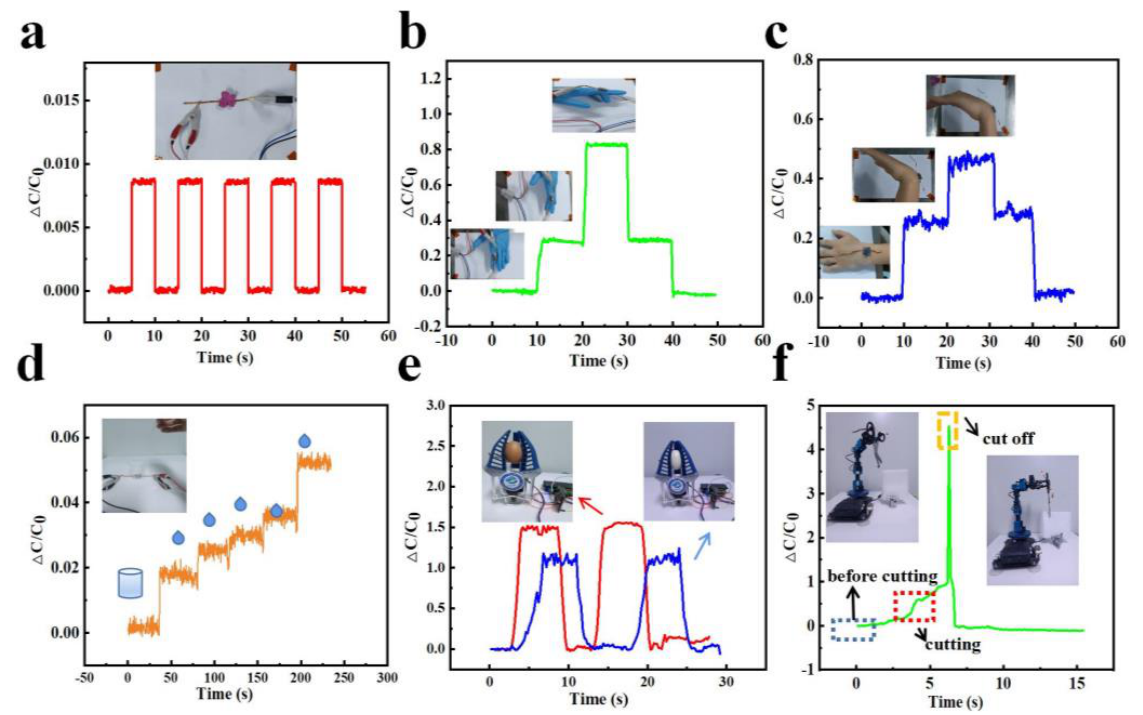
Figure 4. Application tests of the PHHDL-based sensor. ( a ) The tactile sensor repeated real-time responses to a small pressure of ≈30 Pa. ( b , c ) Real-time responses of the tactile sensor when the finger or twist joint bent from 0 degrees to 90 degrees and then returned to 0 degrees. ( d ) The dynamic response of ΔC/C 0 when another drop of water fell into the cup. ( e ) The capacitance changes of the sensor attached to the mechanical claw when the claw grabbed a fresh egg and a peeled egg. ( f ) The capacitance curve of the flexible pressure sensor when the grasped scissor cut a plastic